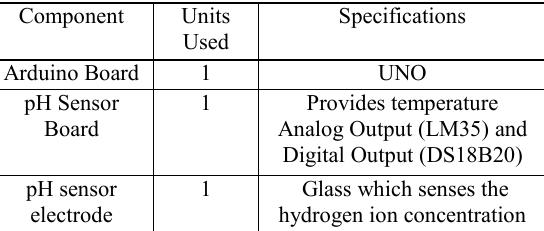
Table 2. Requirement specification for the experiment